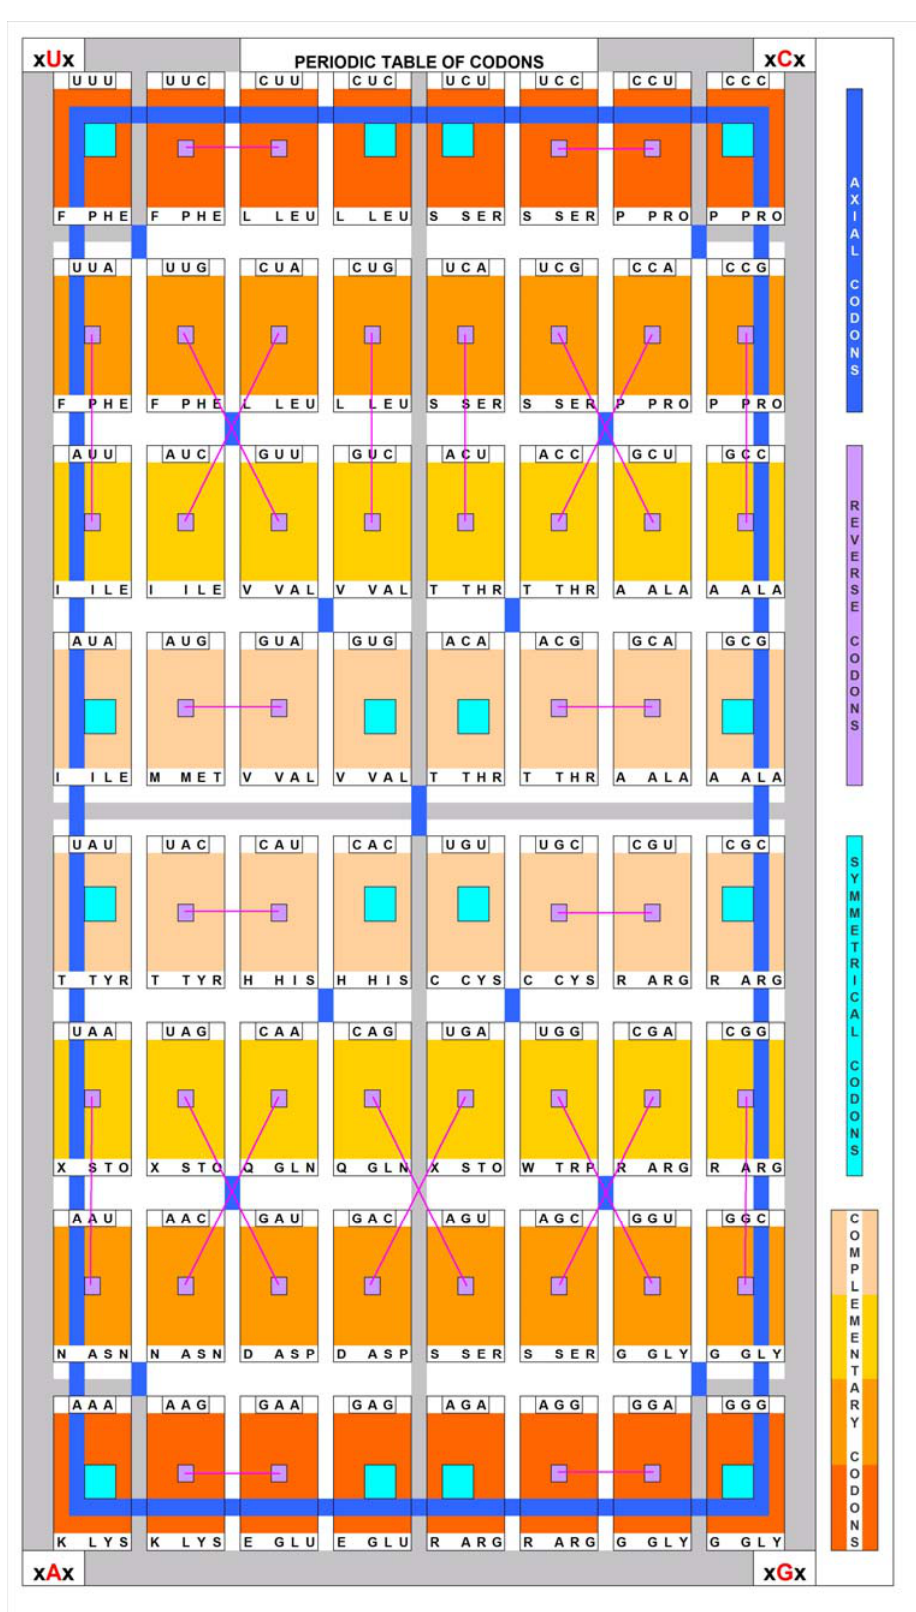
Table 1. The Common Periodic Table of Codons and Amino Acids. a. Periodic Table of